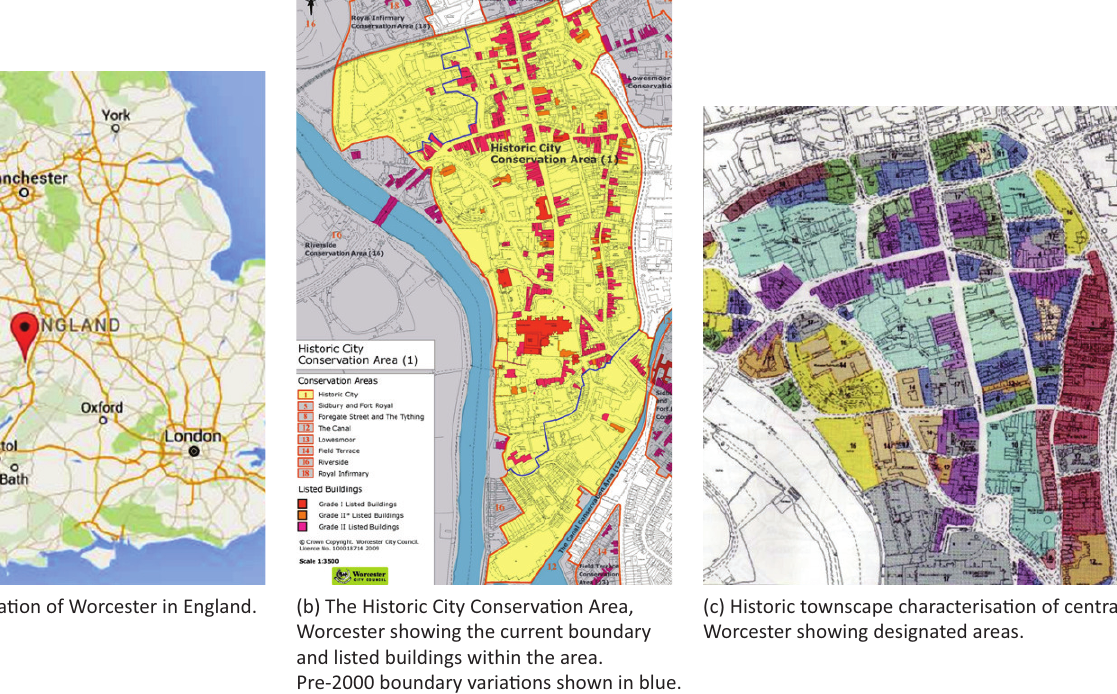
Figure 1. The case study area. Sources: (a) World Easy Guides (n.d.), (b) WCC (n.d.), (c) Baker et al. (2004, p.